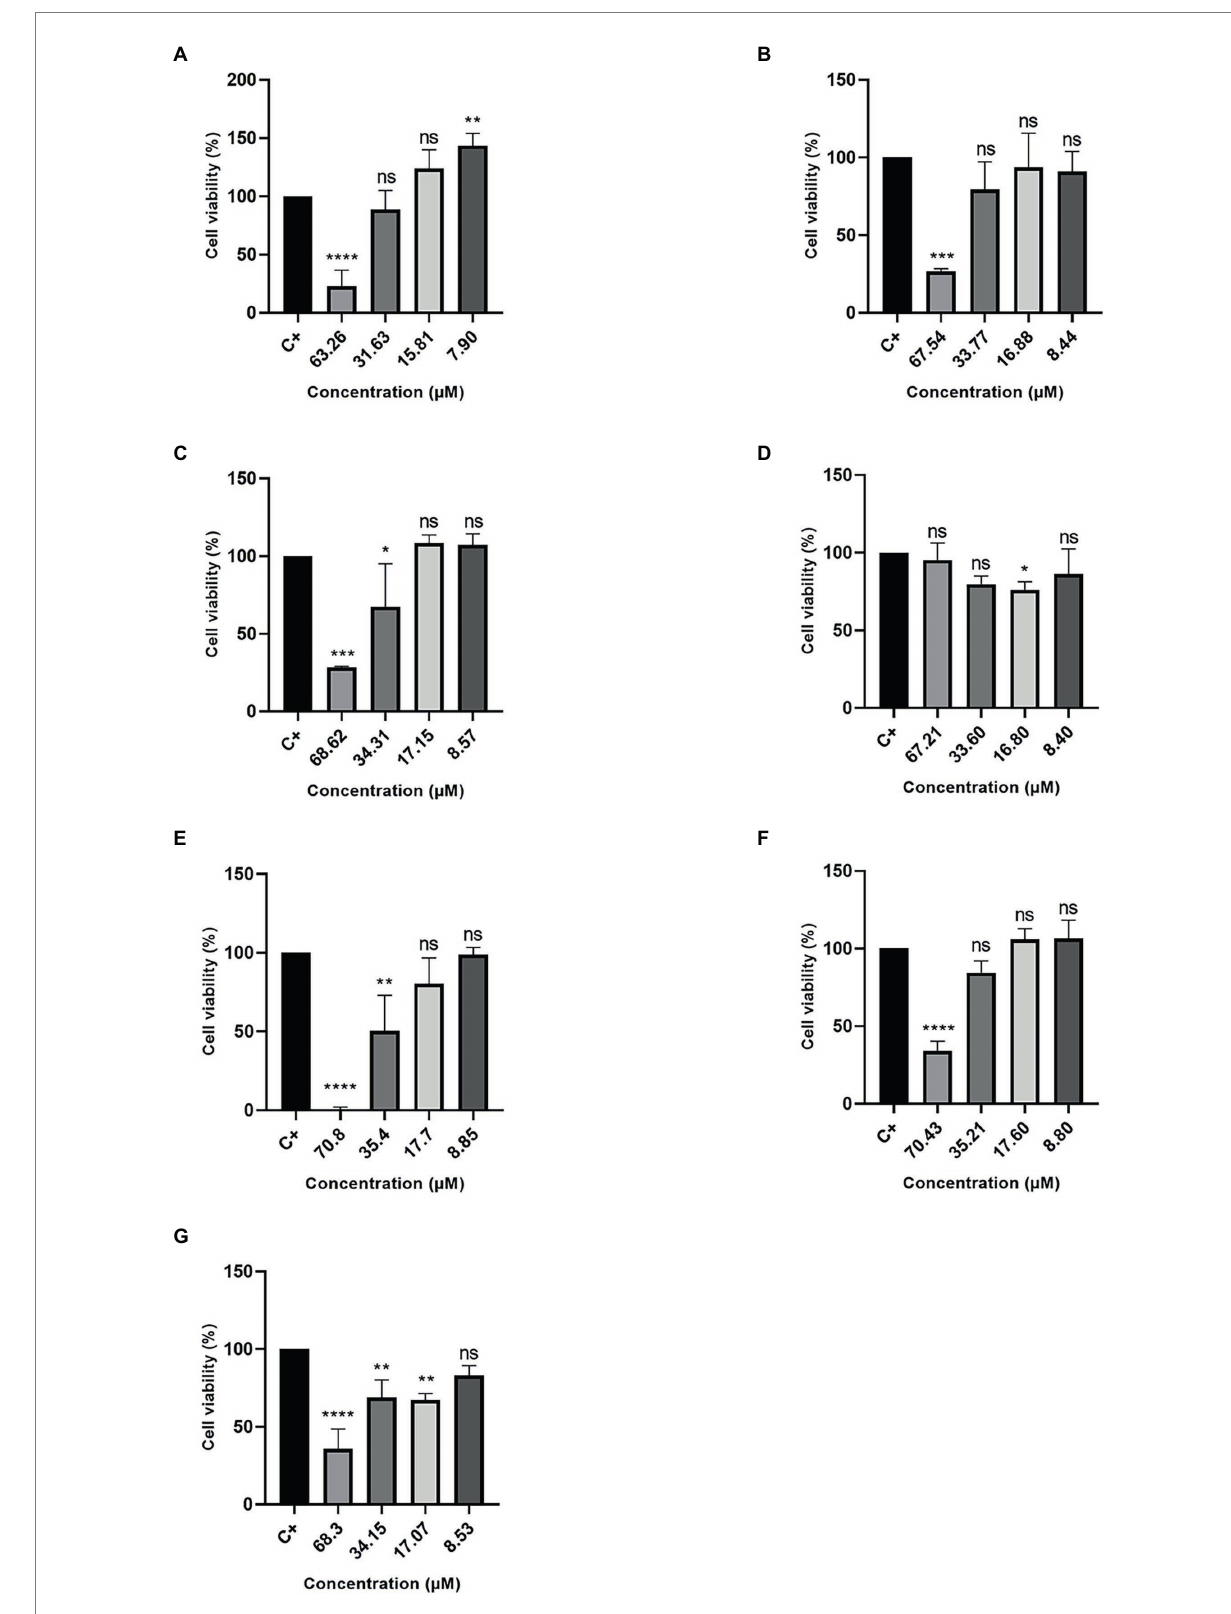
FIGURE 3 Percentage of Cell Viability in HFib cells. (A) R1a; (B) R1b; (C) R2b; (D) R3b; (E) R6b; (F) R8b; and (G) R10b. One-way ANOVA—Bonferroni’s multiple comparisons test. Each bar represents the mean ± SD of cellular absorbance; N = 3. * p < 0.05, ** p < 0.01, *** p < 0.001, **** p < 0.0001, and NS p >